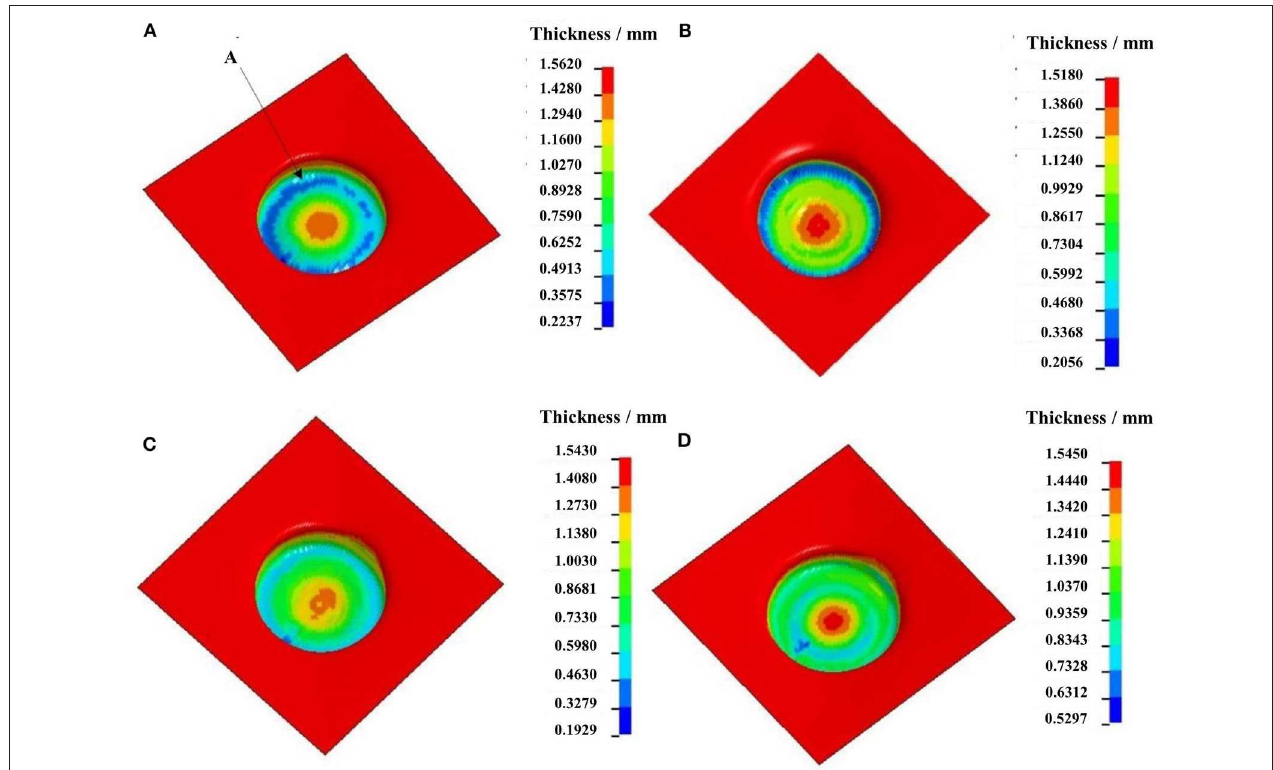
FIGURE 5 | Wall thickness contour of formed parts by different number of forming stages: (A) two-stage SPIF; (B) three-stage SPTF; (C) four-stage SPIF; (D) five-stage